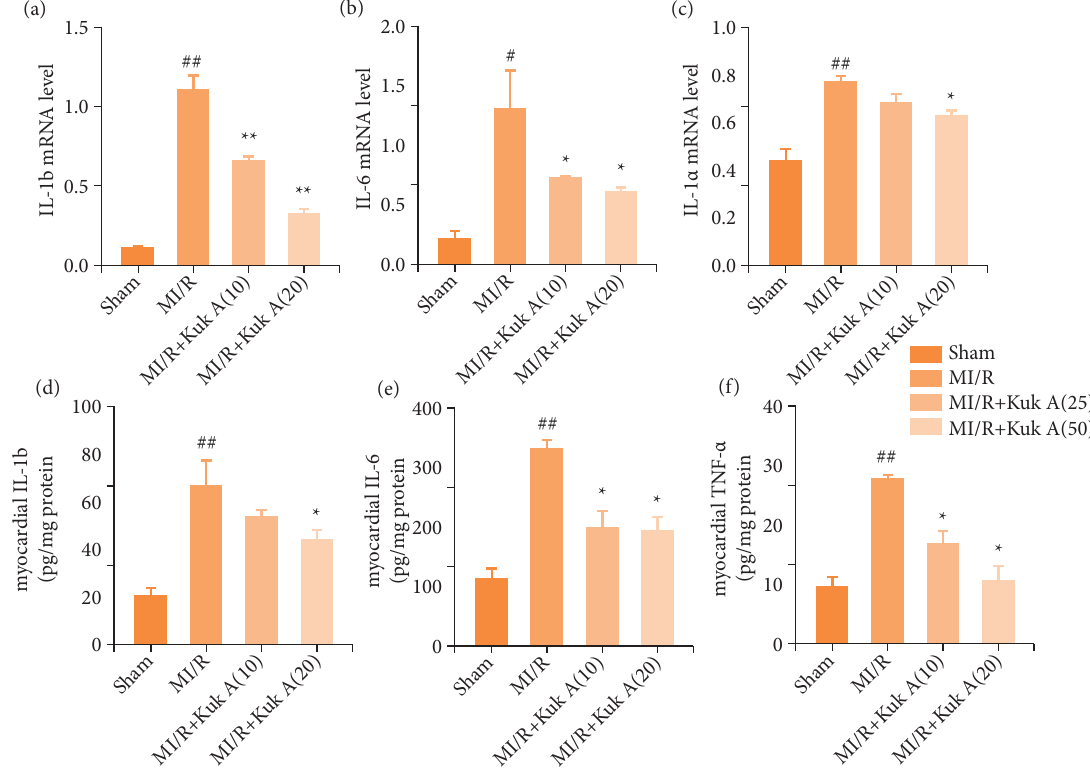
Figure 4 - Effect of KukA on inflammation factors after MI/R treatment in